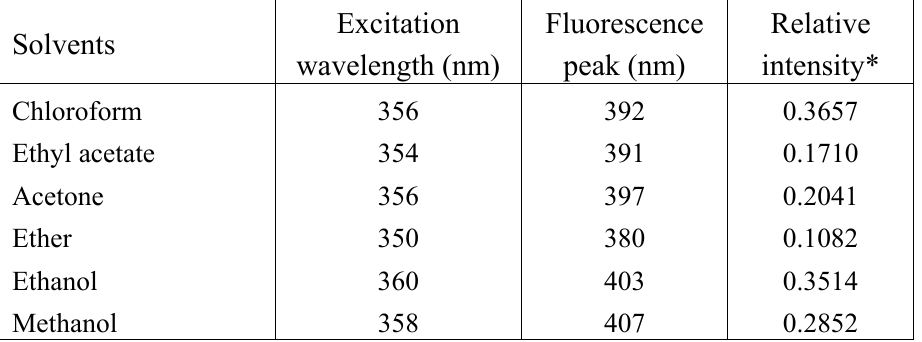
Table 3. Fluorescence peak of 2- N -piperidinopyrimidine in various